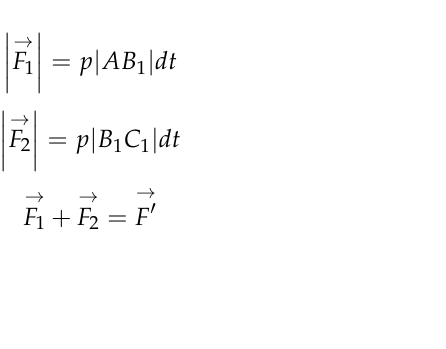
Figure 8. Actuator slice analysis. ( a ) Slice position. ( b ) Key structure A B C